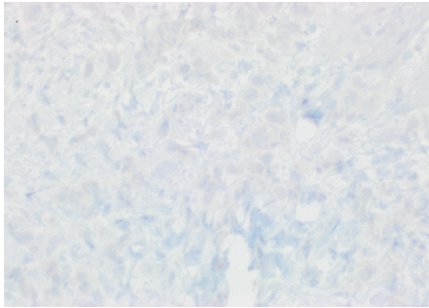
Figure 5: Immunohistochemical stain for CDX-2, a marker of gas- trointestinal